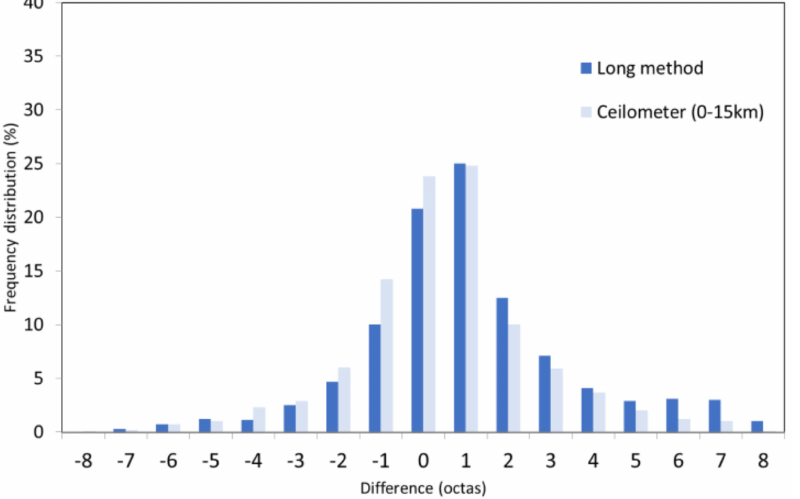
Figure 4. Frequency distribution (%) of absolute difference, in octas, of the total cloud amount derived by the visual and automatic